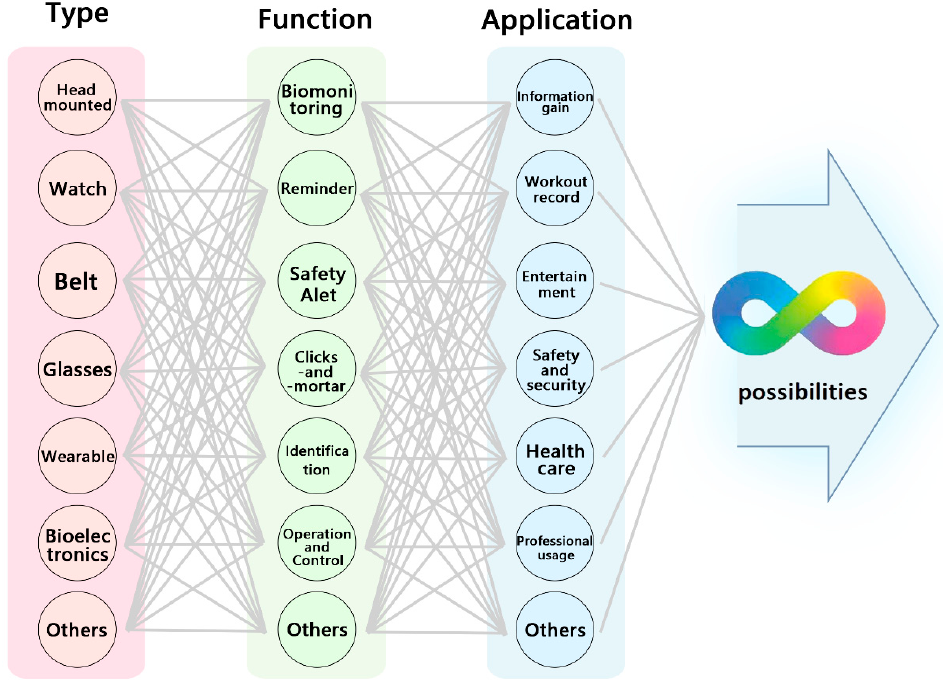
Figure 2. Application of wearable technology. Different shapes and materials are combined with various sensors and functions and adapted to specific applications, showing the potential of wearable devices. Different types of wearables, such as watches, bracelets, headphones, hats, shoes, clothes, necklaces, belts, patches, prosthetics, and glasses, have been developed. Wearables with functions related to biomonitoring, reminders, safety alerts, click and mortar retailing, identification, operation and control have been proposed. Finally, the functions can be applied for information gain, workout records, entertainment, safety and security, health care, and professional usage [8,9].